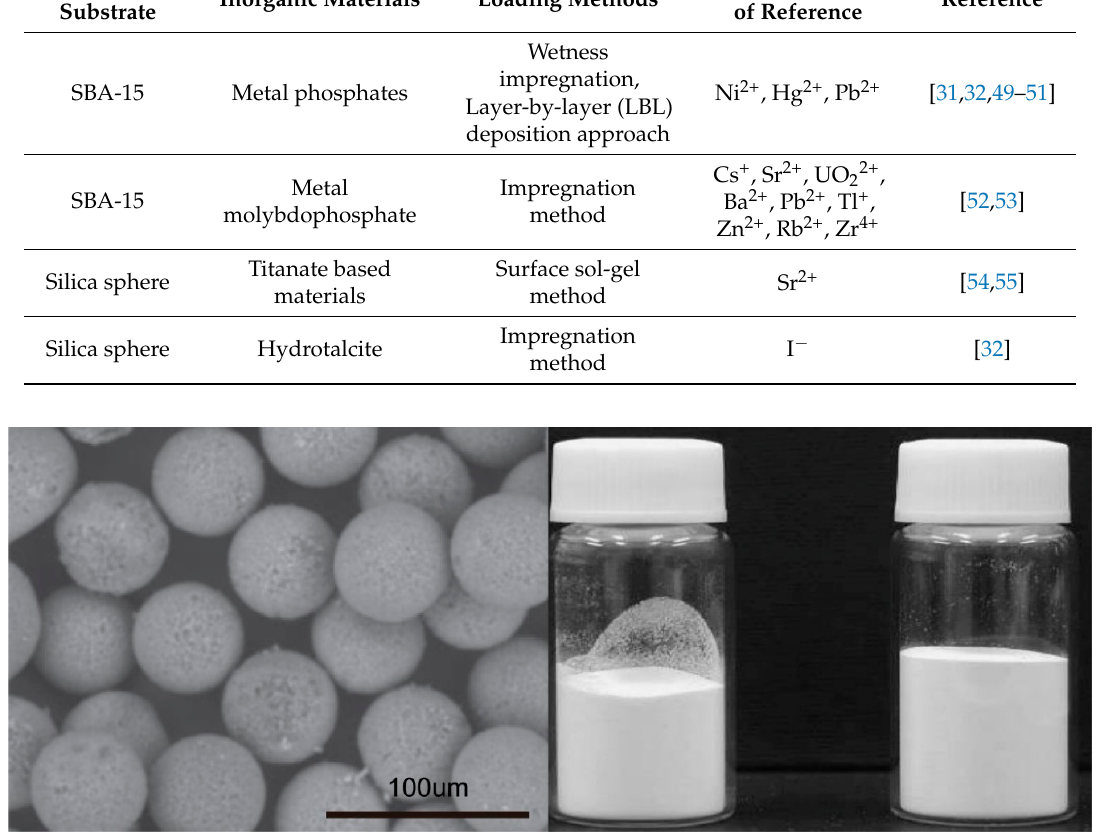
Figure 2. SiO 2 -P and SiO 2 -P modified with organic groups [48].